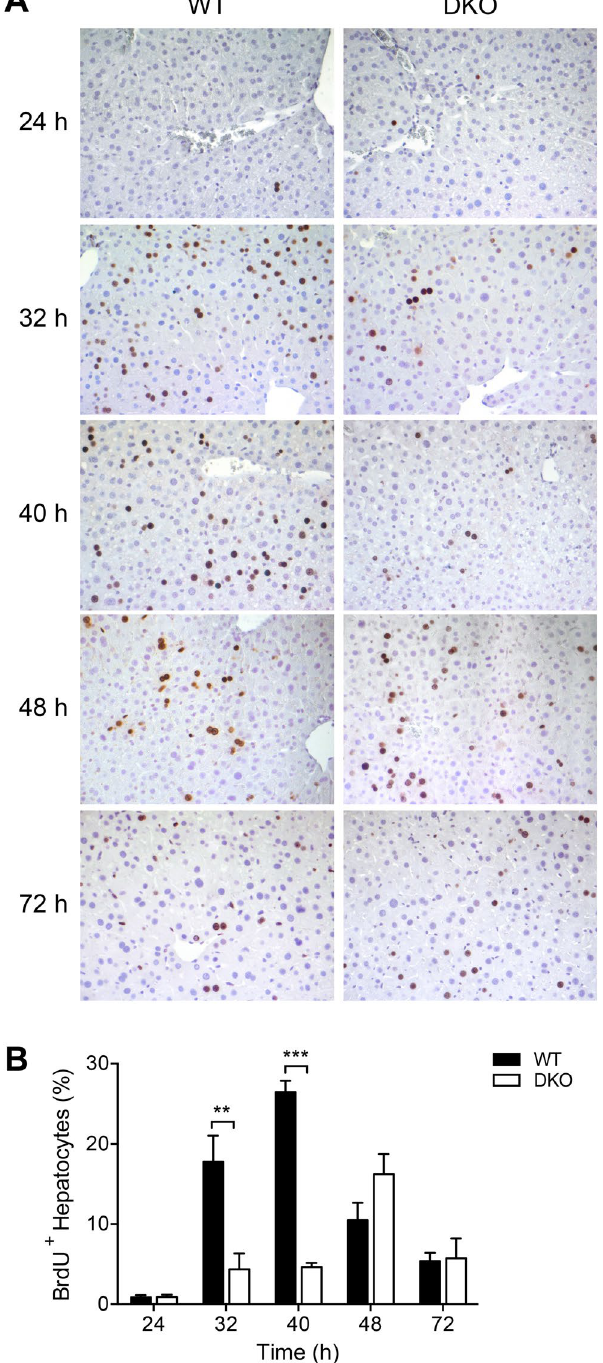
Figure 3. Entry of hepatocytes into S-phase of the cell cycle is impaired in mice with defective cytosolic nucleic acid sensing pathways. Representative immunohistochemical images (A) and quantification of the fraction of BrdU-positive hepatocytes (B) are shown. For each time point and in each group samples from 6 to 8 independent mice were analysed. ** P < 0.01 *** P < 0.001 (two-tailed unpaired Student’s t-test or the Mann- Whitney U